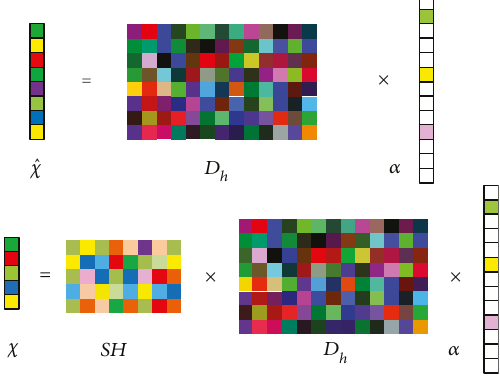
Figure 1: Example of sparse